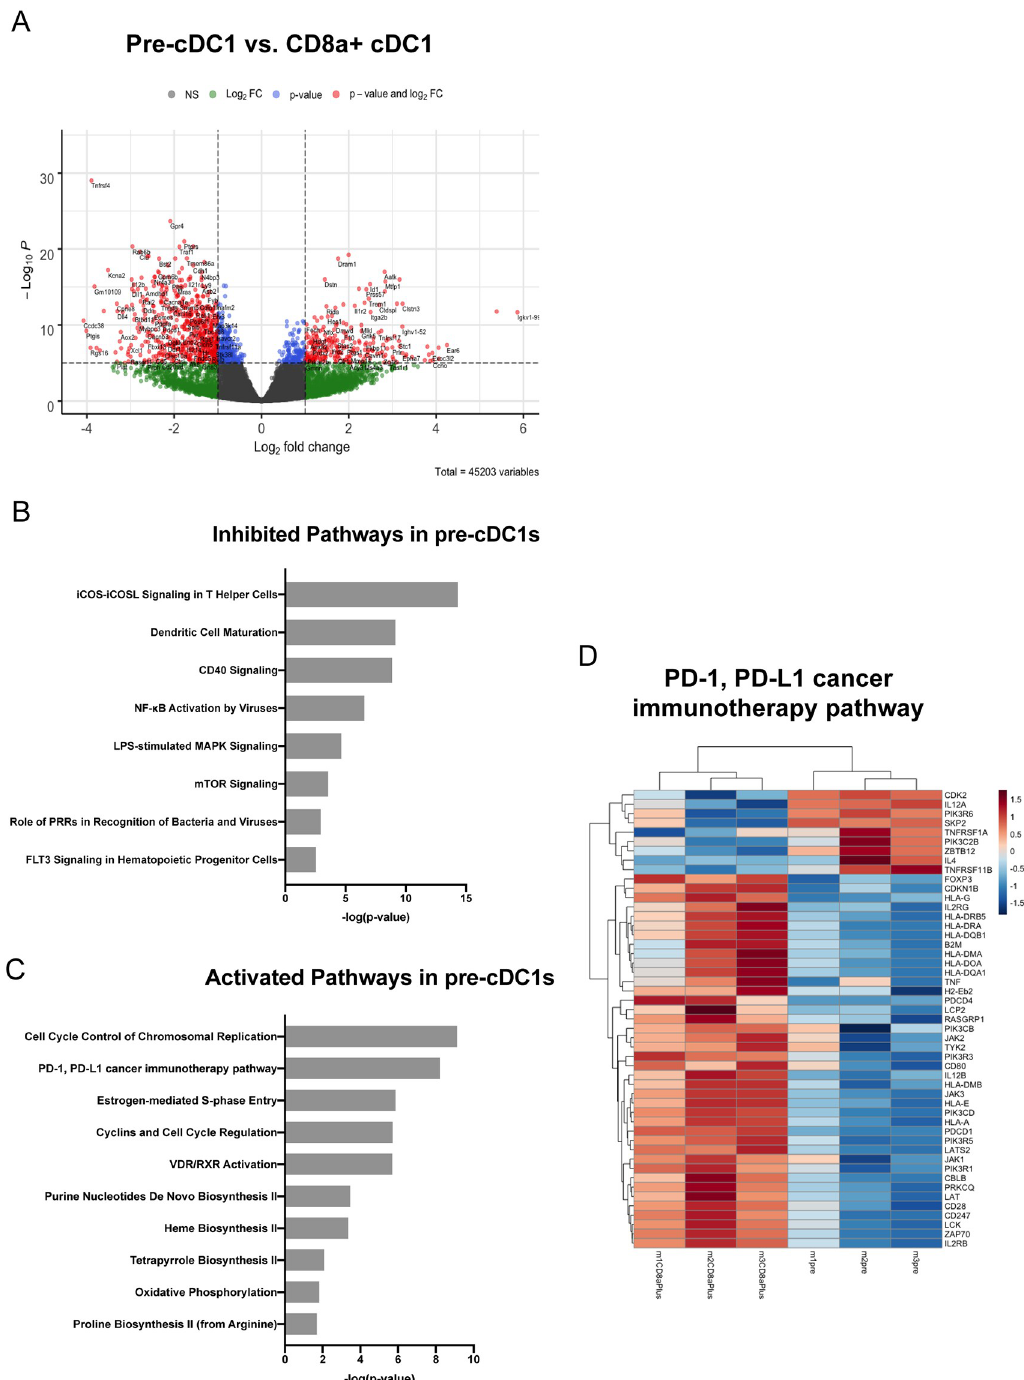
Fig 6. Pre-cDC1 and CD8 α + cDC1 exhibit distinct transcriptional programs. Splenic DCs were isolated from na ï ve BALB/c mice and pre-cDC1s and CD8 α + cDC1s were cell sorted for RNA sequencing. (A) Enhanced volcano plot identifying genes that are up or down-regulated in pre-cDC1s compared to CD8 α + cDC1s. (B-C) Pathway results using Qiagen’s IPA software. P = 0.05 corresponds to a 1.3 -log p-value, and anything above this value is considered statistically significant. (B) Pathways predicted to be significantly inhibited (z-score < -2) in pre-cDC1s compared to CD8 α + cDC1s. (C) Pathways predicted to be significantly activated (z-score < 2) in pre-cDC1s compared to CD8 α + cDC1s. (D) Heat map showing relative gene expression levels for the PD-1/PD-L1 cancer immunotherapy pathway. Full documentation, methodology, and raw data for this data set is available online at: https://doi.org/10.25422/azu.data.14241902.